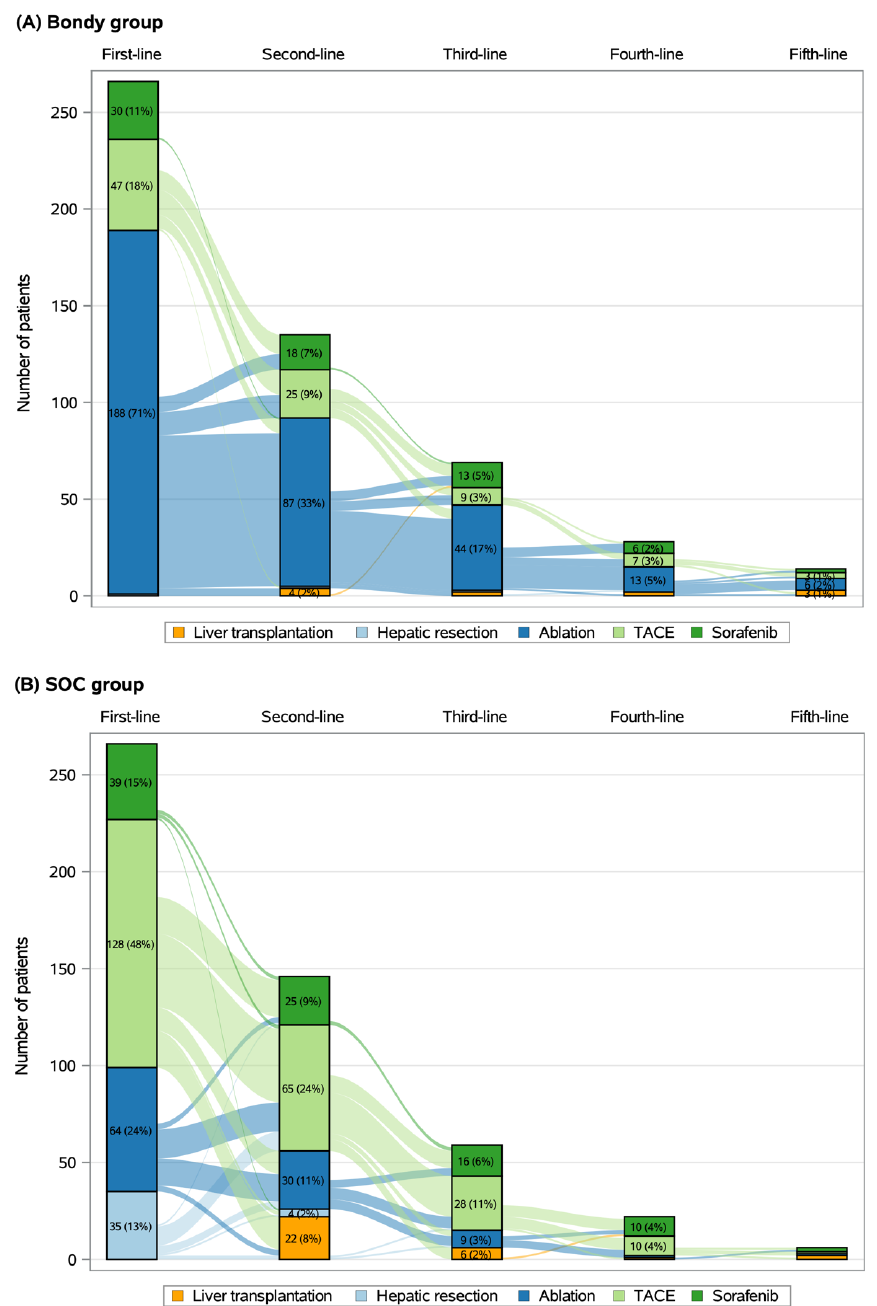
Figure 4. Therapeutic trajectories after first-line treatment in the matched ( A ) Bondy and ( B ) SOC group. The flows between bars are proportional to the number of patients at each step.